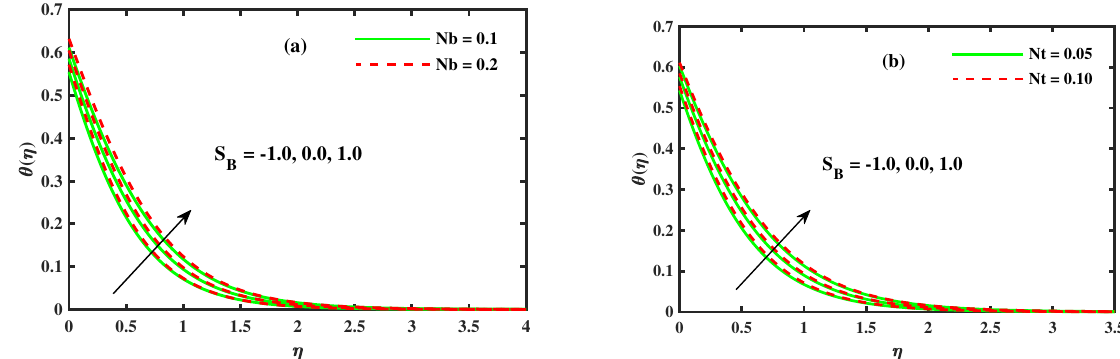
Figure 9. The impact of θ ( η ) for ( a ) Brownian motion Nb and ( b ) thermophoresis Nt .